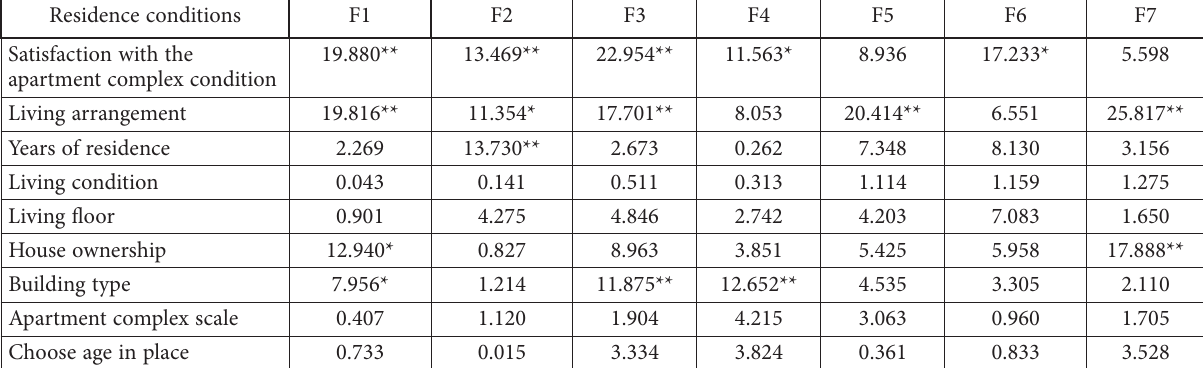
Table 7. Chi-square test results between residence conditions and the demand clusters of each service demand